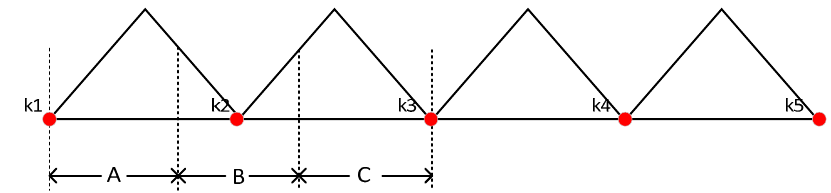
Figure 22. The sketch map of the trajectory of IMU-foot. There are four gait cycles in this figure. Red dots represent that IMU-foot is on the ground which is the mid-stance.